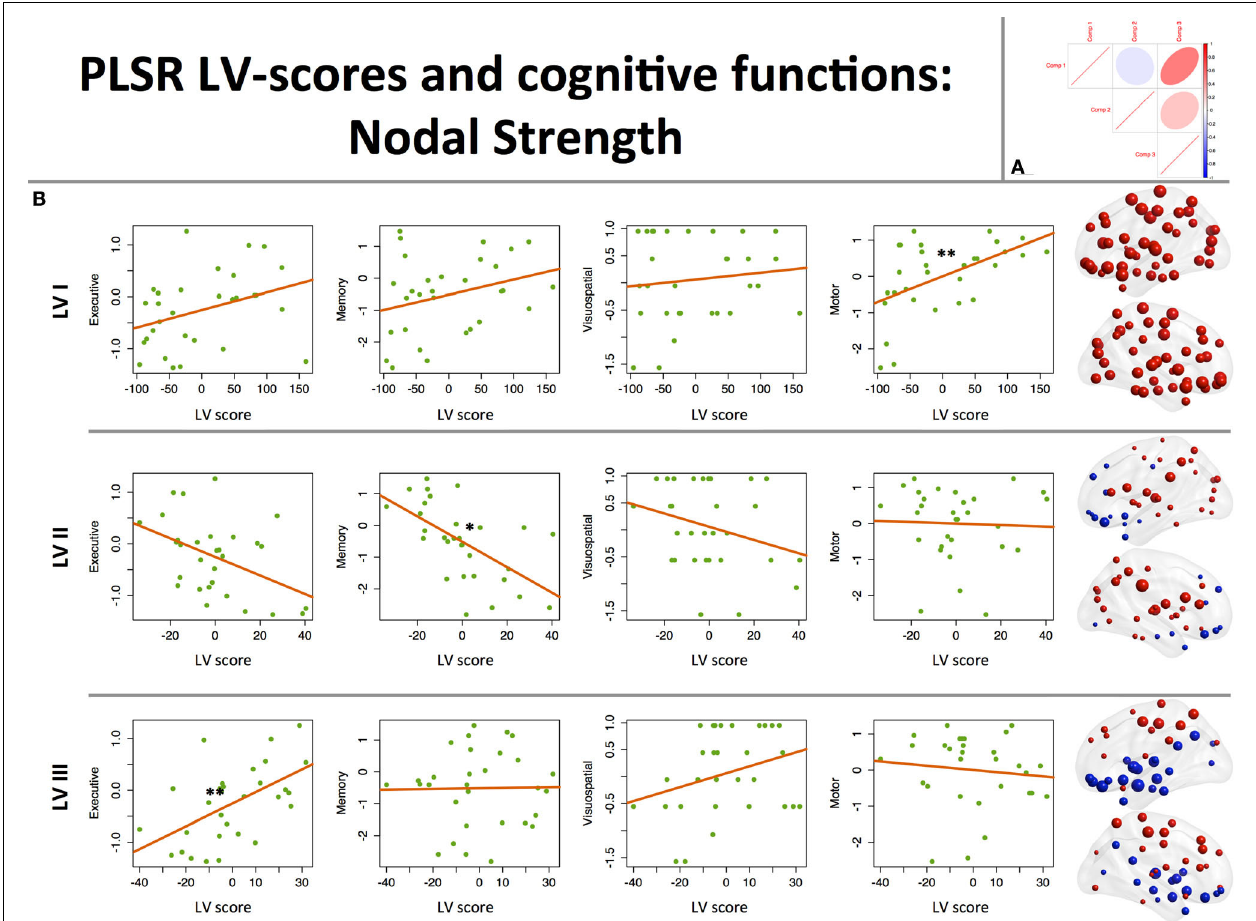
FIGURE 1 | Associations between component scores and behavioral data: nodal strength. (A) Between-component correlation plot. Positive association ( r = 0 . 5) was found between latent variables (LVs) I and III. (B) Associations between LV scores extracted from the nodal strength data and performance in 3 cognitive (executive, memory, visuospatial) and motor